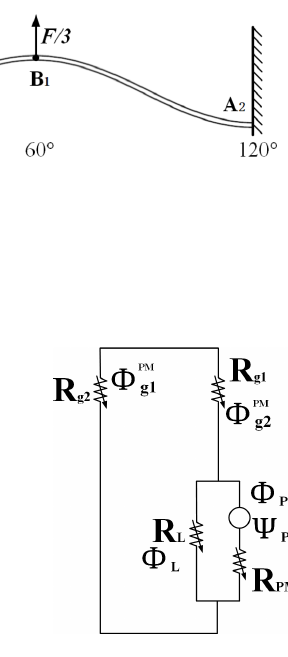
Figure 5. Equivalent magnetic circuit of power-off